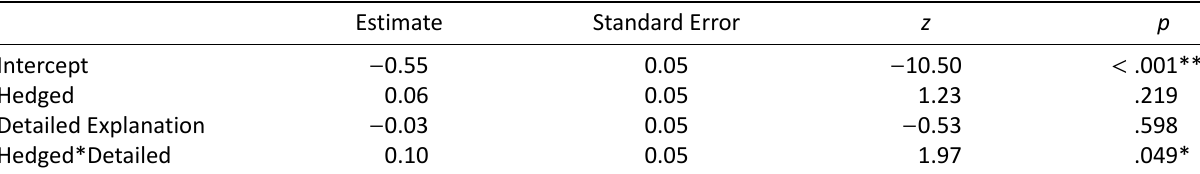
Table 1. Logistic regression predicting likelihood of reply to corrective message.